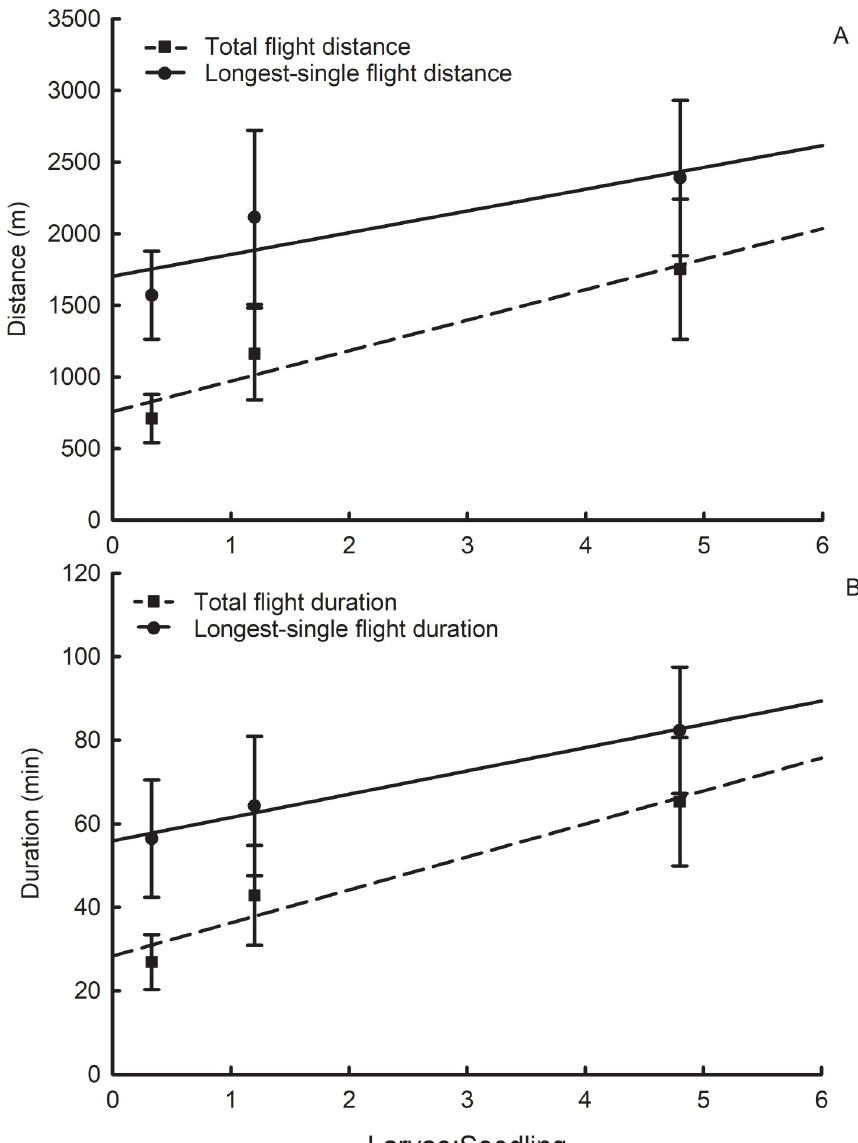
Fig 4. Influence of western corn rootworm larval rearing densities on (A) flight distance, and (B) flight duration, in the voluntary flight experiment. Points represent sample means, and error bars indicate SEM. Linear regression analyses were conducted with raw data. Linear regression of flight parameters (Y) on larval density (X): (Total flight distance) df = 1, 156, Y = 213.29X + 765.55, t = 2.05, P = 0.0421, r 2 = 0.0262; (Longest single flight distance) df = 1, 43, Y = 109.60X + 1738.07, t = 0.72, P = 0.4784, r 2 = 0.0118; (Total flight duration) df = 1, 156, Y = 7.84X + 29.10, t = 2.18, P = 0.0304, r 2 = 0.0297; (Longest single flight duration) df = 1, 43, Y = 4.47X + 56.91, t = 0.99, P = 0.3290, r 2 = 0.0222.